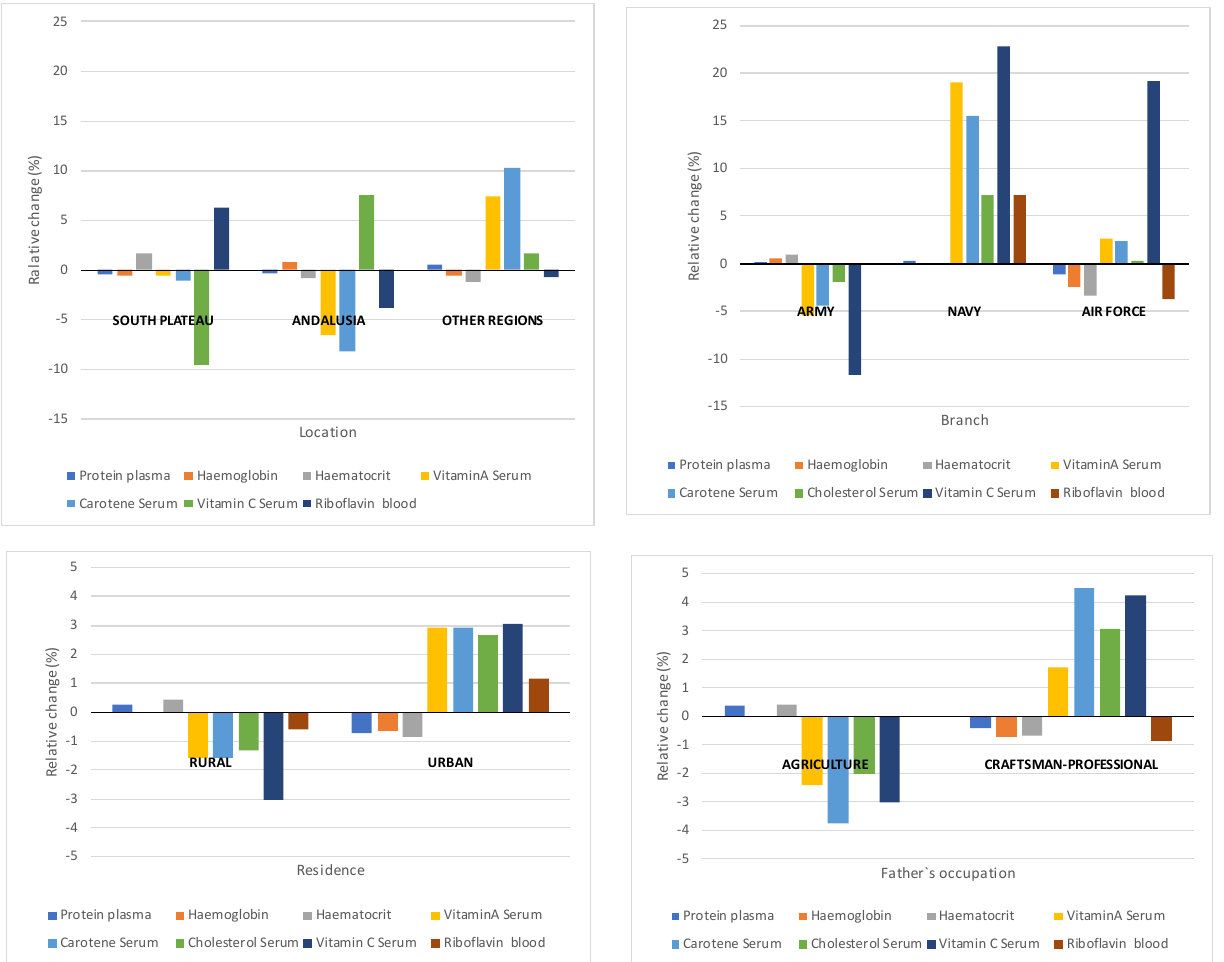
Figure 5. Relative variation of biochemical indicators in blood and urine tests according to tabulation variables.